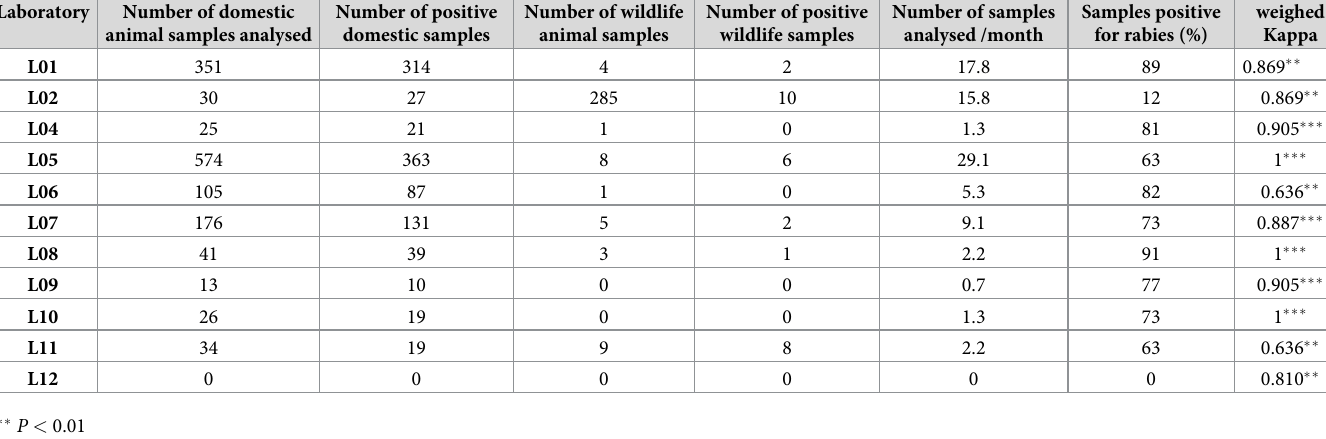
Table 6. Information on routine diagnostic activities. The technical questionnaire reported information on the diagnostic activities carried out between January 2016 and September 2017. The number of samples from both domestic and wildlife animals and the confirmed rabies positive cases were communicated. Based on the quantity of samples analysed monthly, a weighted K was